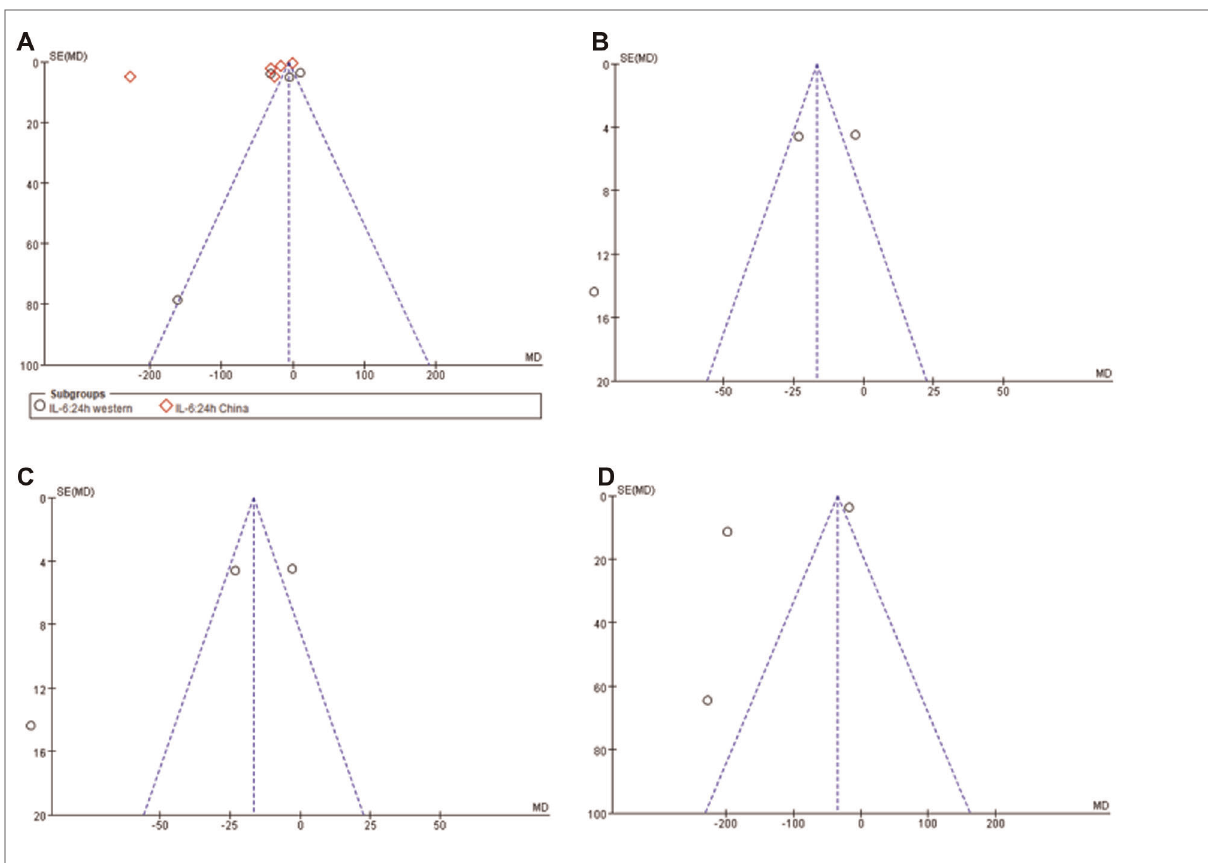
FIGURE 10 Funnel plot examination for postoperative 24 h in fl ammatory